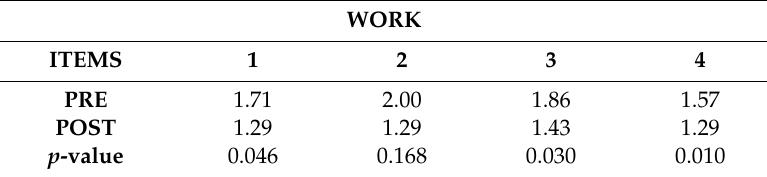
Table 3. DASH work and DASH sport score.